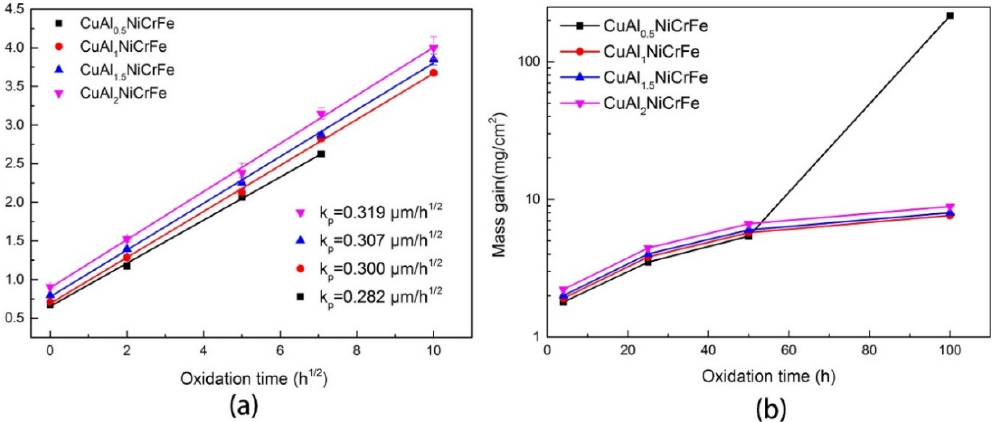
Figure 19. ( a ) shows TGO thickness evolution ( b ) mass gain at isothermal oxidation at 1100 °C of the CuAl x NiCrFe (x = 0.5, 1, 1.5, 2) bond coats. Reprinted with permission from [24] Copyright 2021 Elsevier.